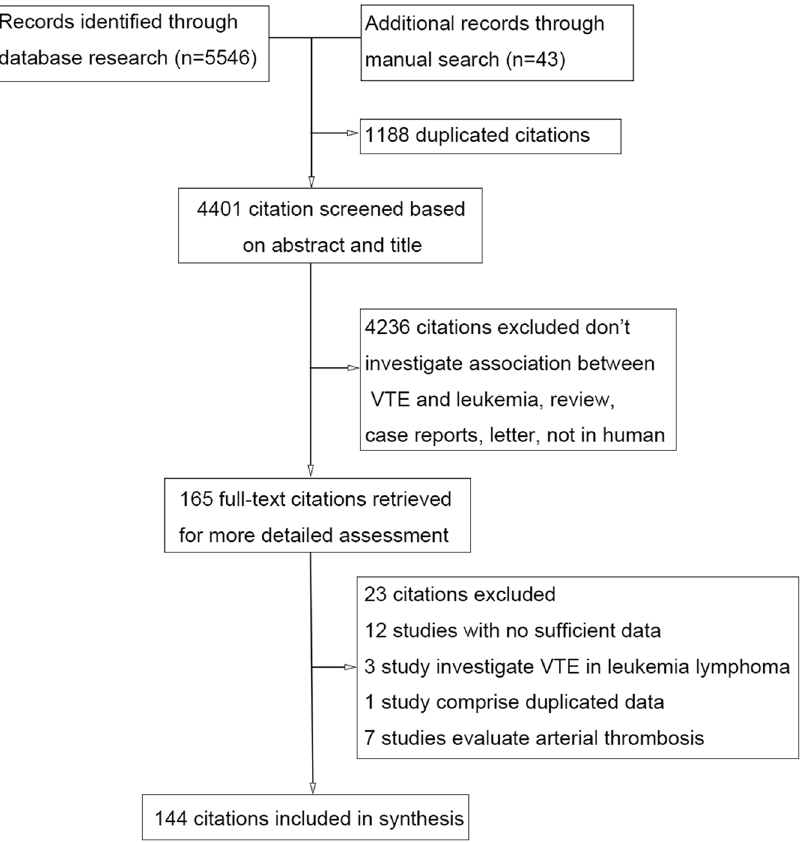
Figure 1. Flowchart of study selection